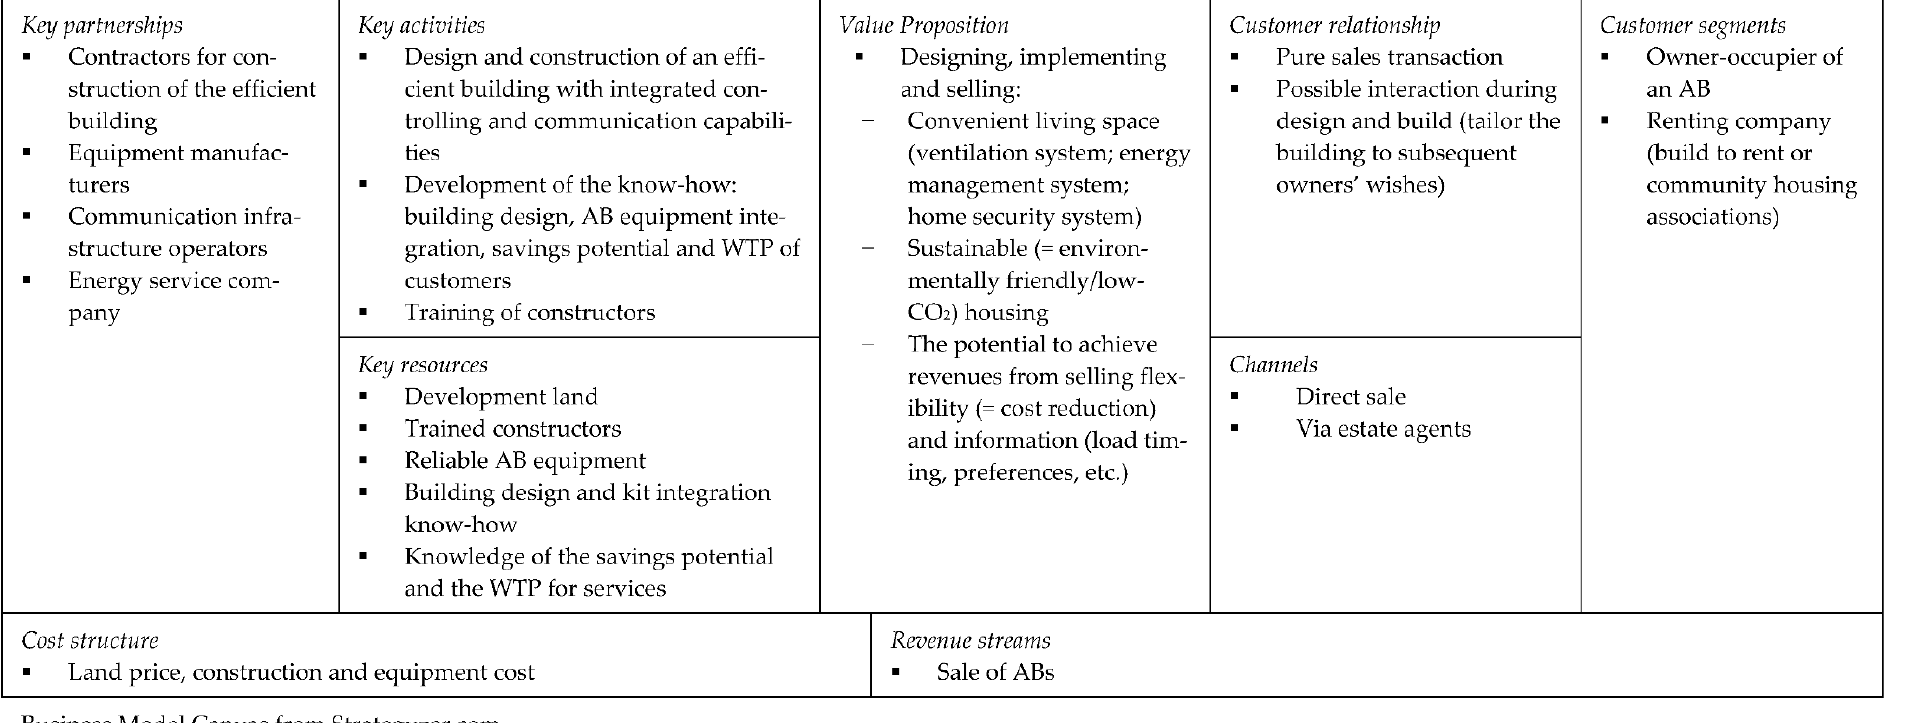
Figure 7. The Build and Transfer model.